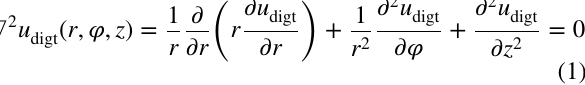
Fig. 3 3D meshed model of MCPA with 164,810 grids, L = 0.05 m, D = 0.03 m, h = 0.002 m, d = 0.0015 m, S = 0.005 m